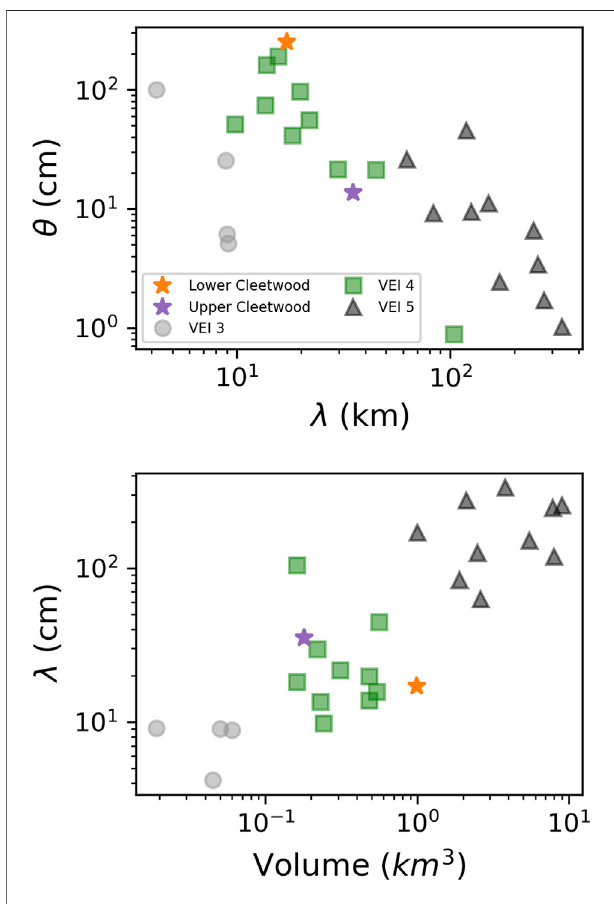
FIGURE 10 | Best fi t Weibull parameters for the three phases of the Cleetwood eruptive sequence plotted together with VEI 3, VEI4, and VEI 5 eruptions compiled by Bonadonna and Costa (2012). (A) θ vs λ . (B) λ vs total erupted volume (non-DRE). In both graphs, note that all three phases of the Cleetwood eruptive sequence plot with other VEI 4